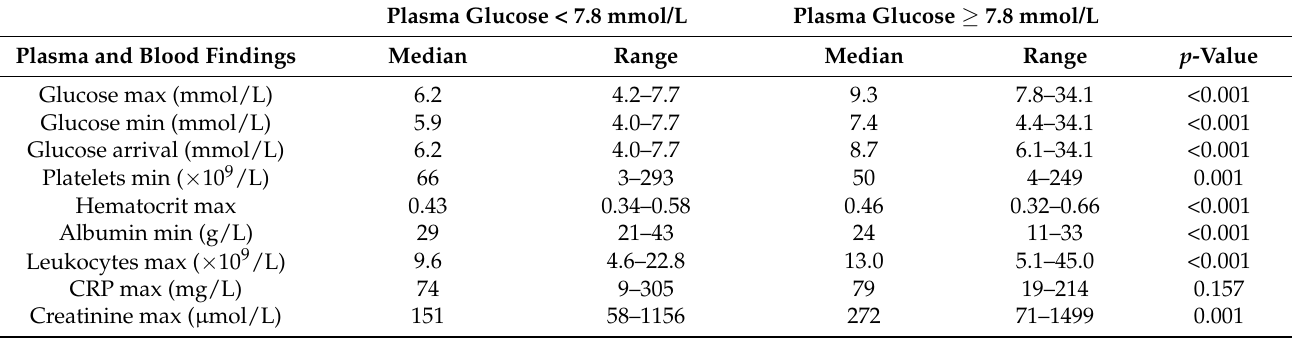
Table 2. Laboratory findings in 185 patients with PUUV infection according to maximum plasma glucose